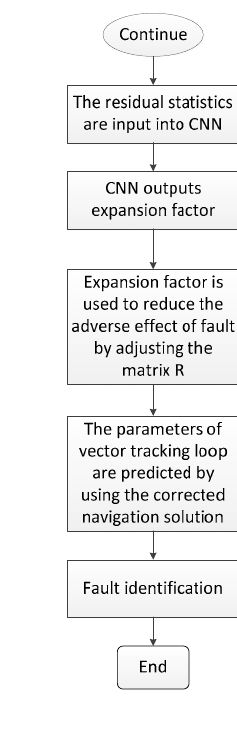
Figure 4. The structure of deep integration assisted by CNN.